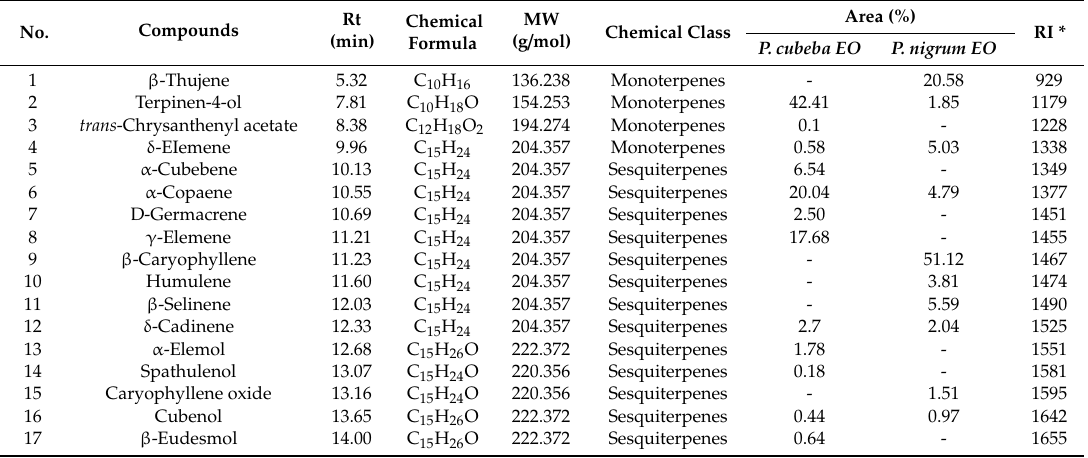
Table 4. Identification of chemical components of P. cubeba and P. nigrum EOs by